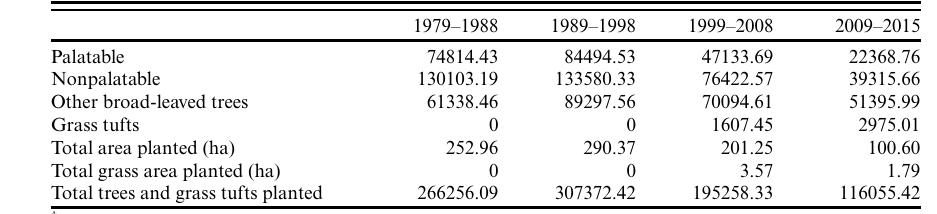
Table 1 . Trees and grass tufts planted † in Himachal Pradesh,